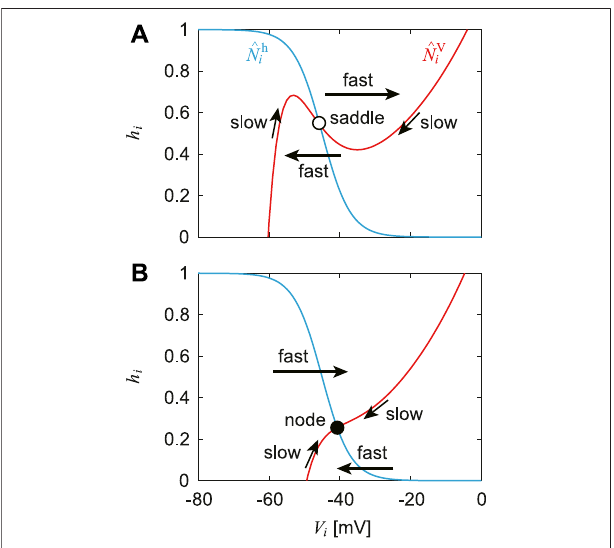
FIGURE2| Nullclines ^ N V i and ^ N h i for i ∈ RG { } ofRGneuronsinthephase plane and fast and slow dynamics that the state ( V i , h i ) for i ∈ RG { } follows. (A) ^ N V fl ection points and intersection with ^ N h i has two different in i is saddle equilibriumpoint. (B) ^ N V i changesmonotonicallyandintersectionwith ^ N h i is stable node equilibrium point. Bold and thin arrows represent fast and slow dynamics,